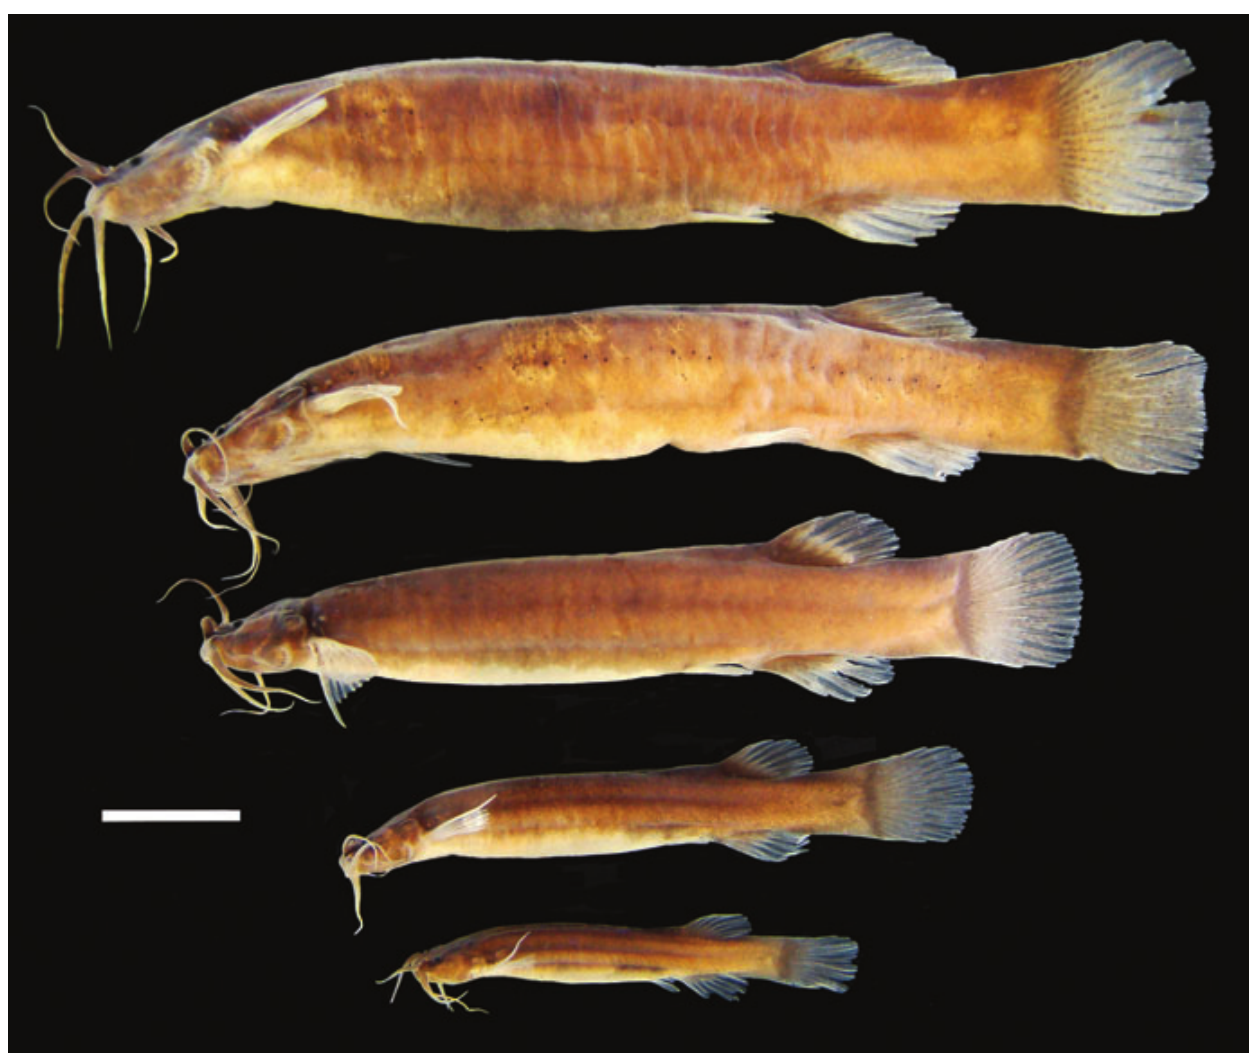
Fig. 3. Ituglanis ina , paratypes, MPEG 17388. Left lateral view showing the gray color pattern and the vertical dark bar on the base of the caudal-fin rays, in large to small specimens. Black spots over body are nematodes’ cysts. Scale bar = 1